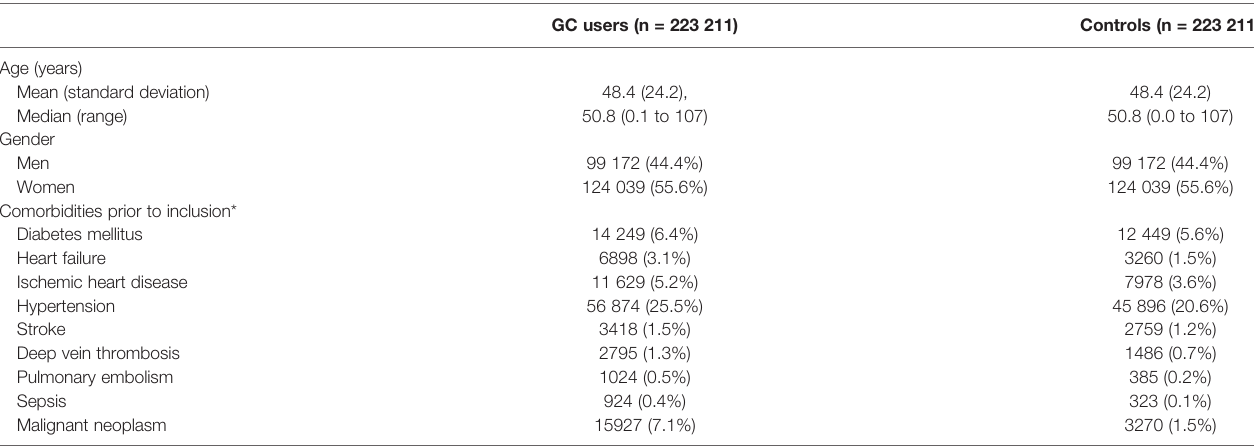
TABLE 2 | Baseline